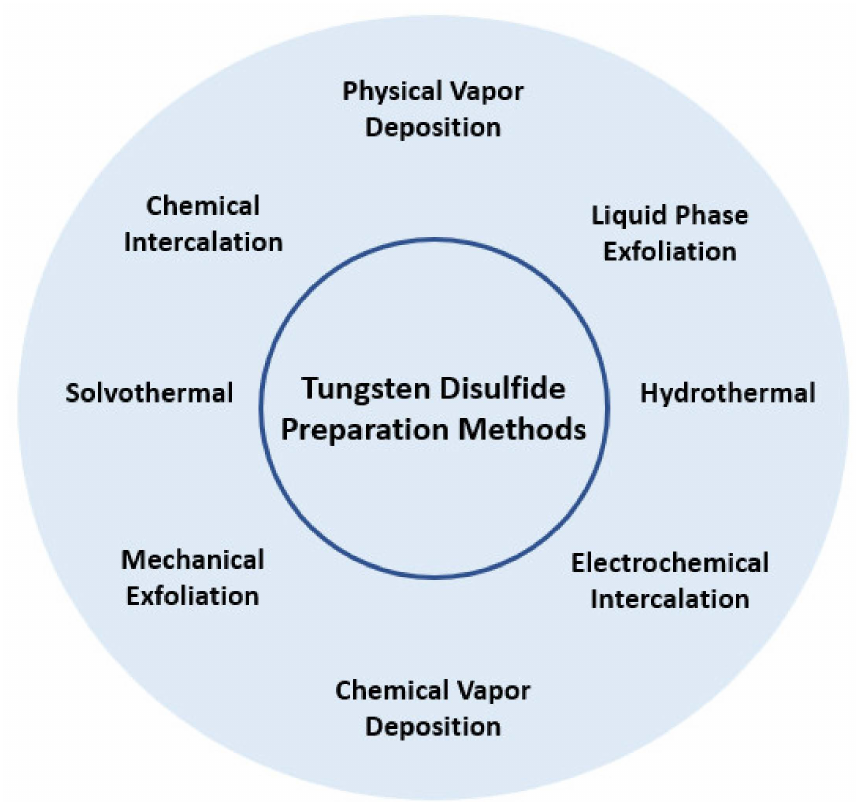
Figure 5. Main tungsten disulfide preparation